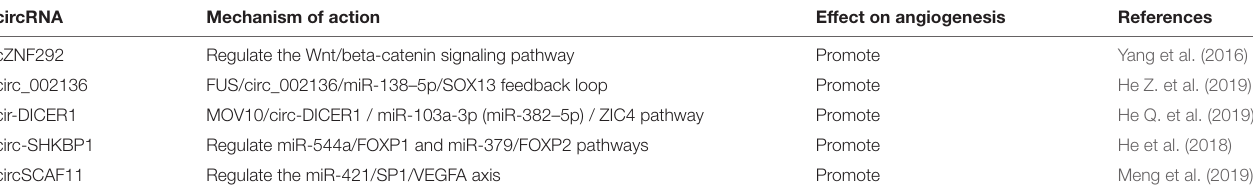
TABLE 3 | circRNAs involved in the regulation of angiogenesis in